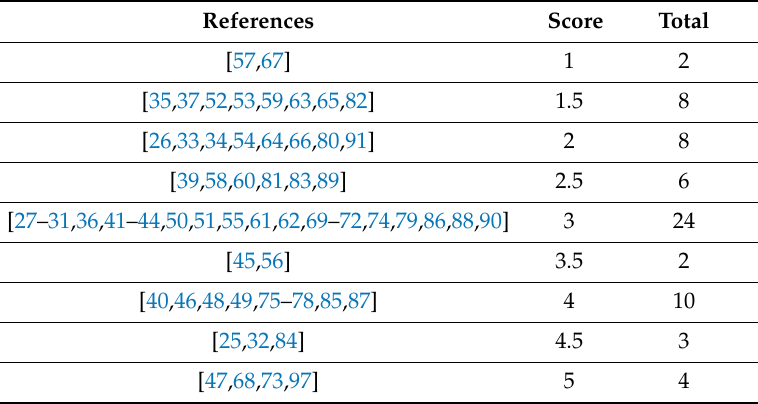
Table 9. Quality assessment score.